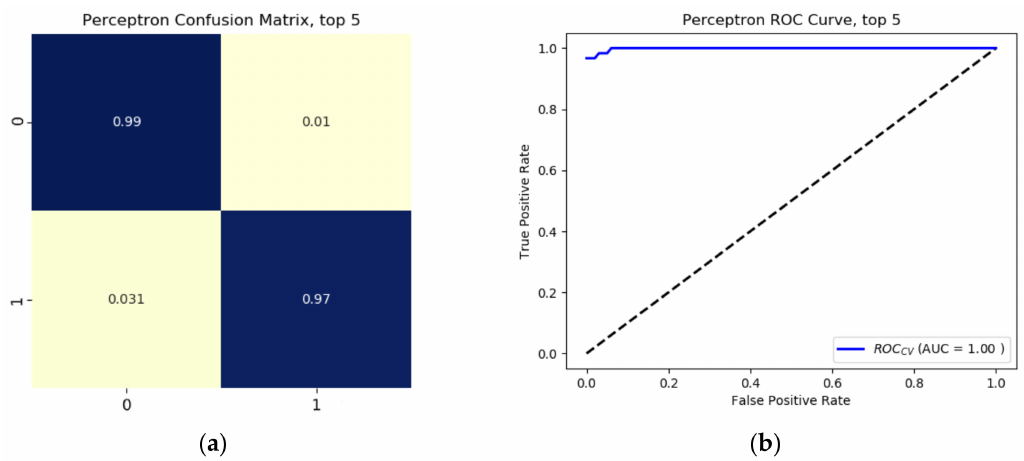
Figure 7. The vegetative growth binary classification for the [CR-spec] data set: ( a ) shows the confusion matrix where class 0 = non-vegetative growth, and class 1 = vegetative growth, while ( b ) shows the associated receiver operating characteristic (ROC)